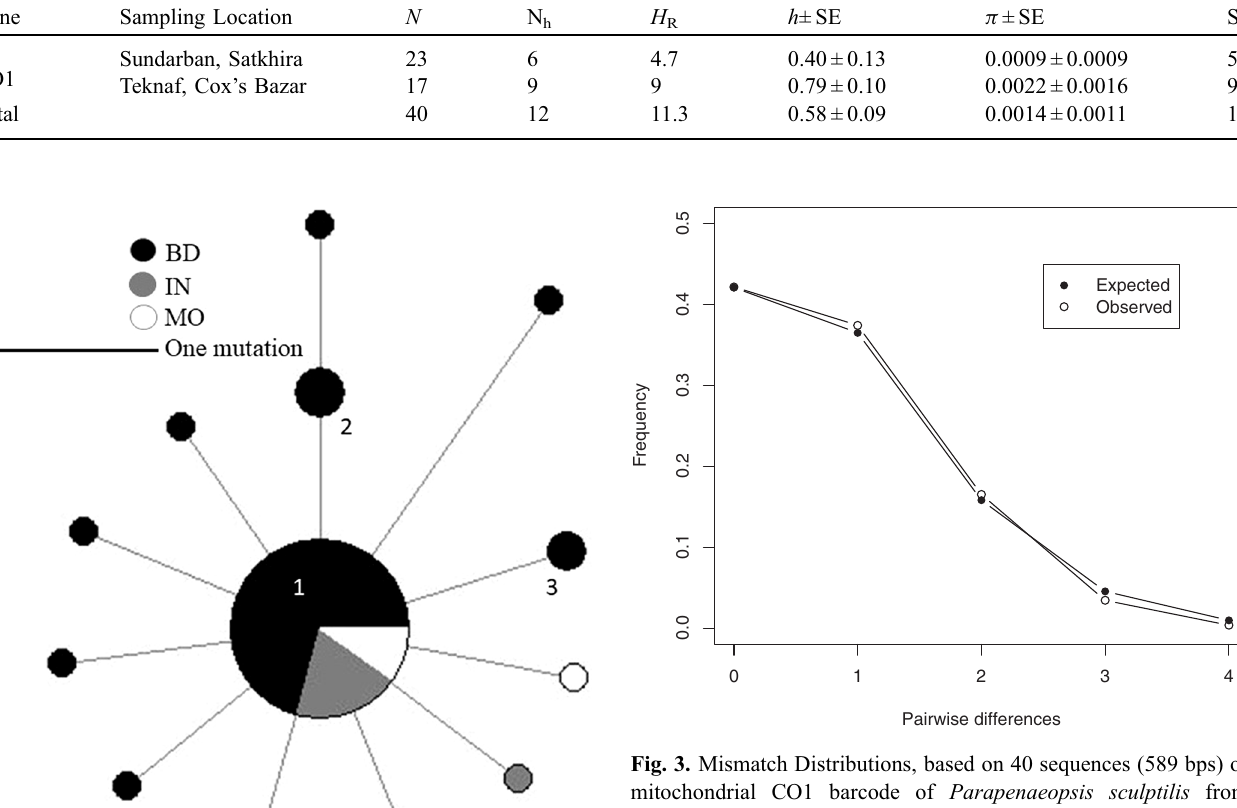
Table 2. Genetic diversity of Parapenaeopsis sculptilis from Bangladesh based on mitochondrial CO1. N = No. of individuals, N h =No. of haplotypes, H R = Haplotype richness, h =haplotype diversity, p = Nucleotide diversity, S =No. of segregating sites, SE = standard error. Gene